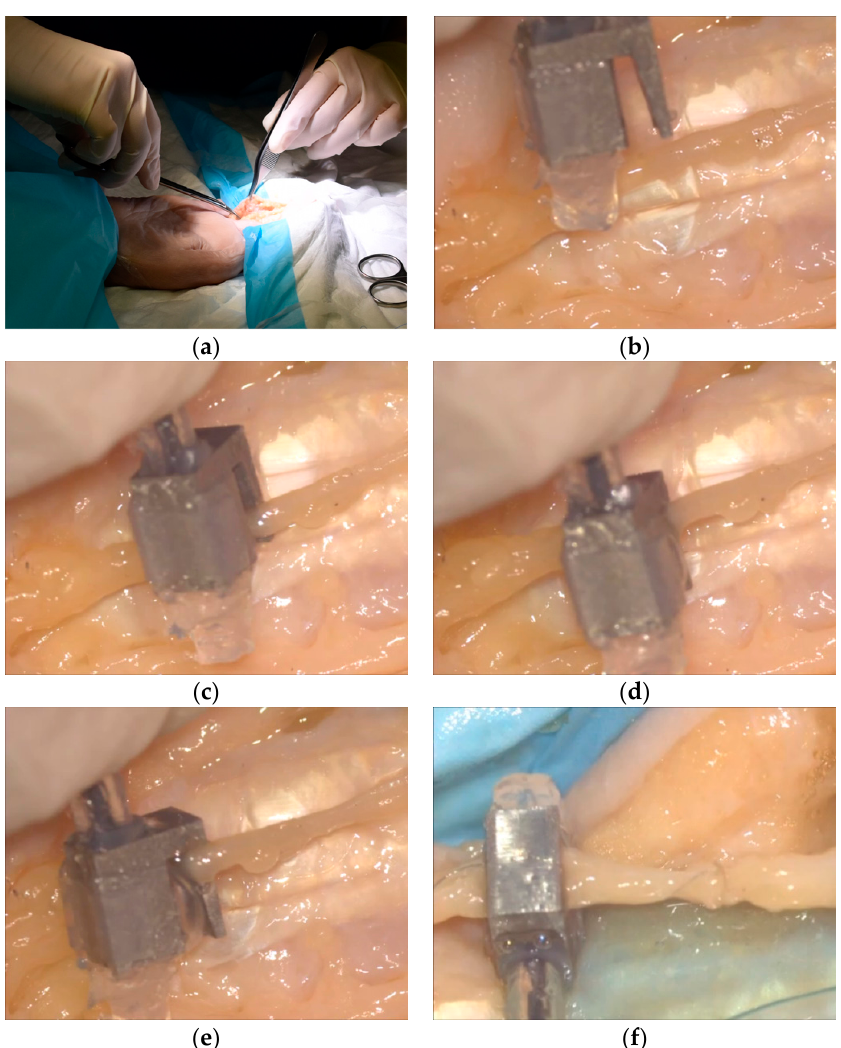
Figure 12. Gripping experiment on a digital nerve located in the middle finger of a cadaver using the proposed soft hybrid surgical gripper (( b – f ) were captured from microscopic view): ( a ) making an incision to expose the digital nerve of the middle finger; ( b ) approaching the digital nerve that needed to be gripped; ( c ) scooping up the digital nerve; ( d ) inflating the soft pneumatic actuator to grip the digital nerve; ( e ) the zoomed-in figure of the inflated balloon; and ( f ) rotating the digital nerve for suturing the reverse side of the digital nerve and for observation.